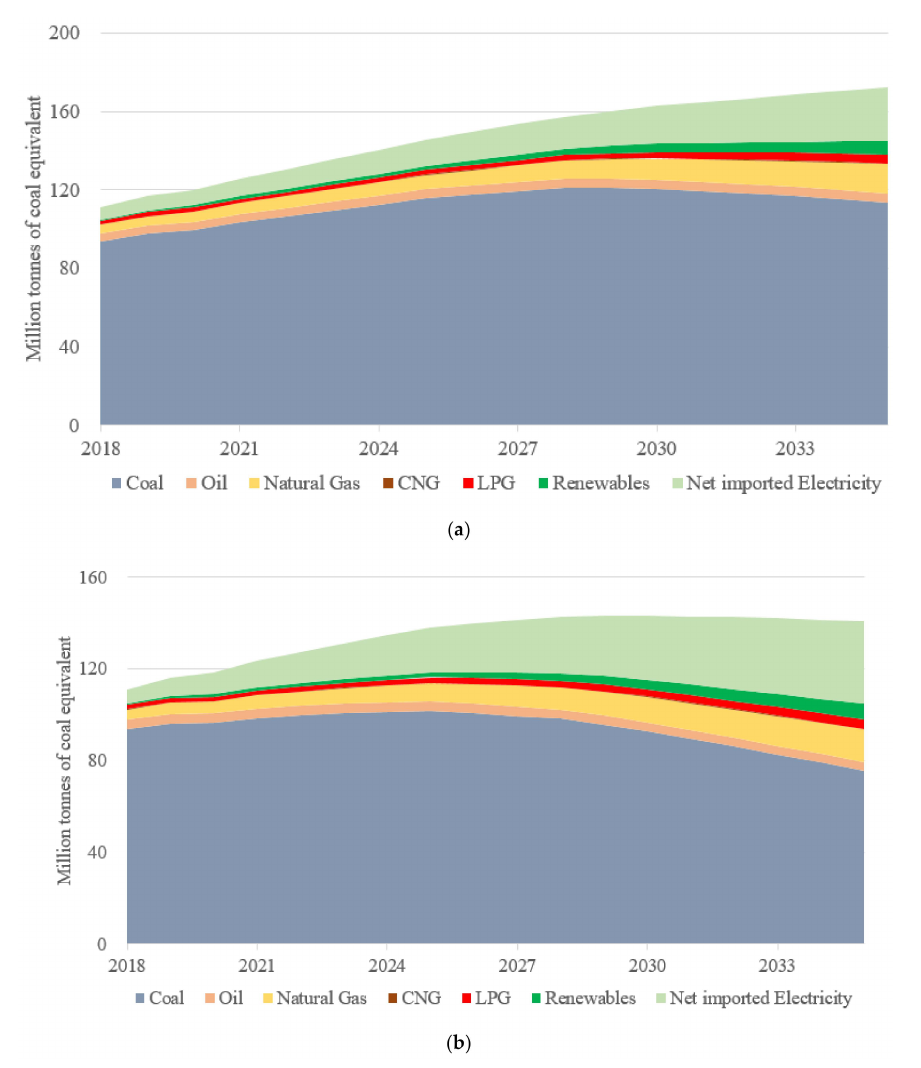
Figure 5. The predictions of city’s energy consumption. ( a ) REF scenario. ( b ) GLC scenario.